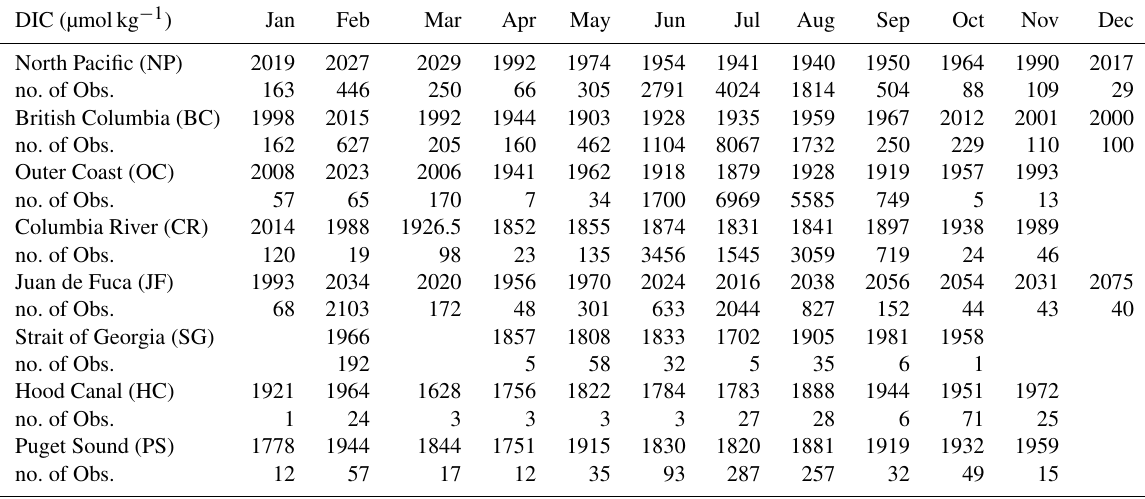
Table B4. Average monthly DIC seasonal cycles for the eight unique regions. The total number of observations (no. of Obs.) contributing to the monthly average estimate is